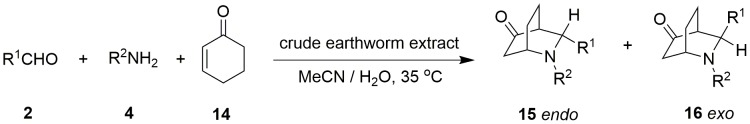
The crude earthworm extract catalysed aza-Diels-Alder reactions.